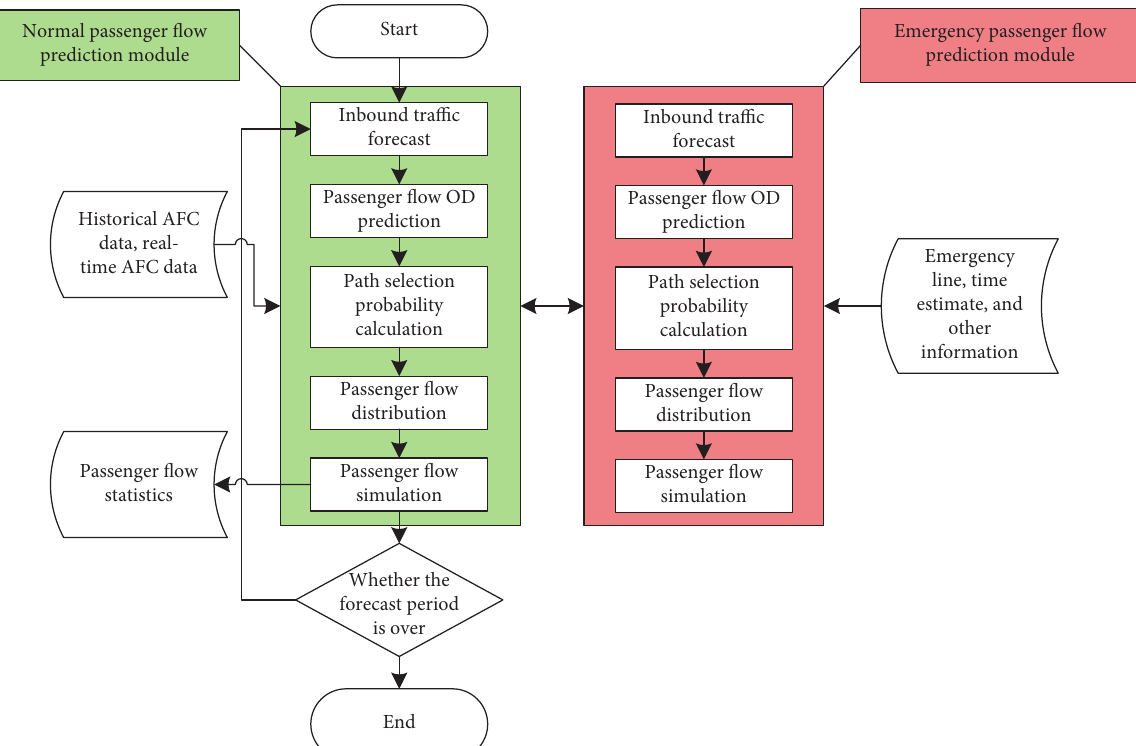
Figure 1: Overall process of the real-time prediction of passenger flow in an urban rail transit